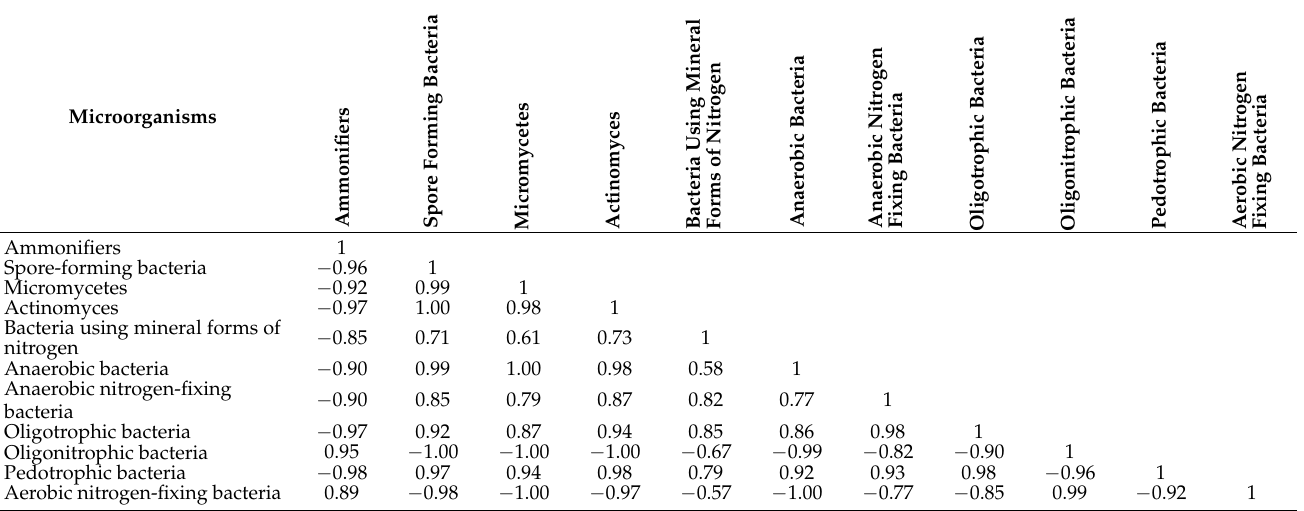
Table 1. The integrity of the soil microbial community in forest ecosystems.